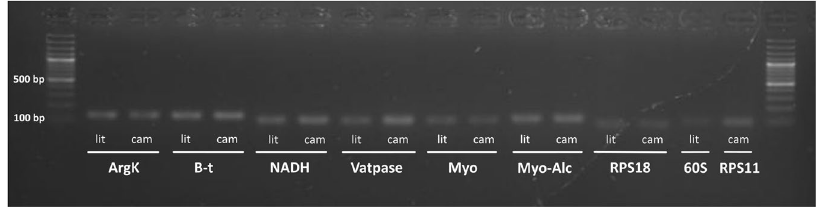
Figure 1. Agarose gel showing the fragments amplified with all the primers selected for qPCR analyses. All fragments showed predicted lenghts for both species (lit: C . littoralis ; cam: C . campestris ). Gel is presented uncropped and no posterior image edition and modification in exposure or contrast were